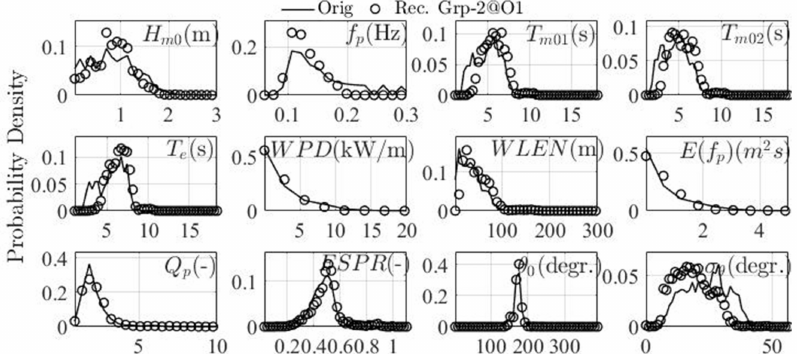
Figure 9. Probability distribution of partition KPs in Grp-2 at check point O1. Probability densities derived from spectra simulated with the original and the reconstructed boundaries are indicated by solid lines and circles, respectively. Each panel is titled according to the corresponding KP, and the x axis in each panel denotes the value range of the